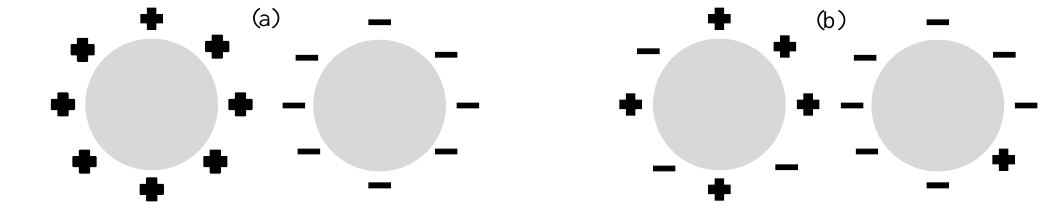
Figure 4. (a) Net Charge Condition / pI and (b) Not a Net Charge